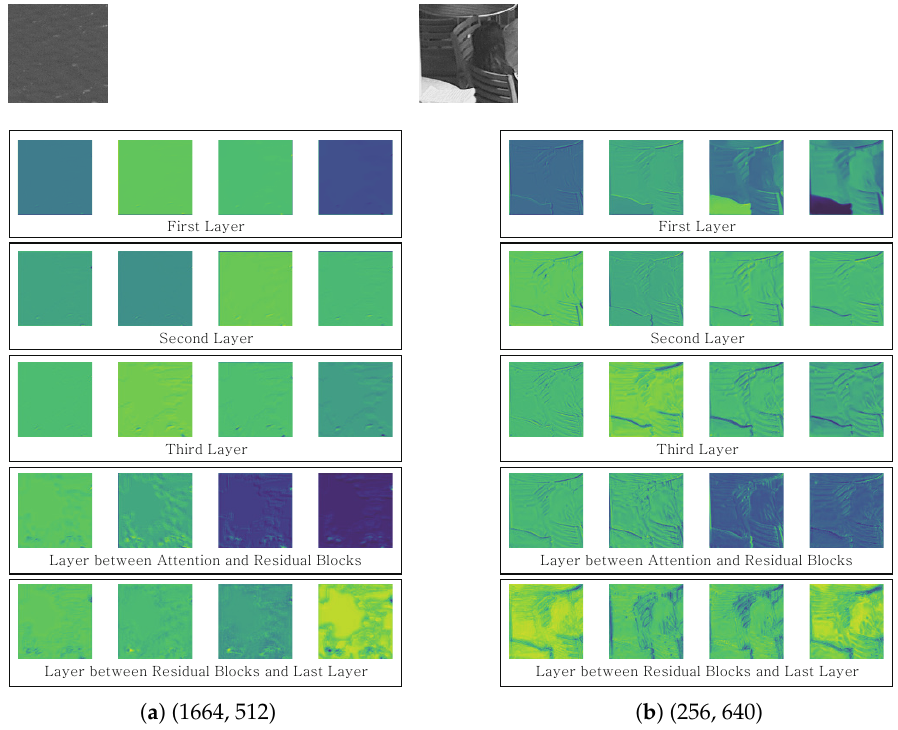
Figure 8. Visualization of output feature maps of CNN layers. Input: 128 × 128 prediction blocks in POC20 of BQTerrace under RA and QP37. ( x , y ) means the top left position of CU in